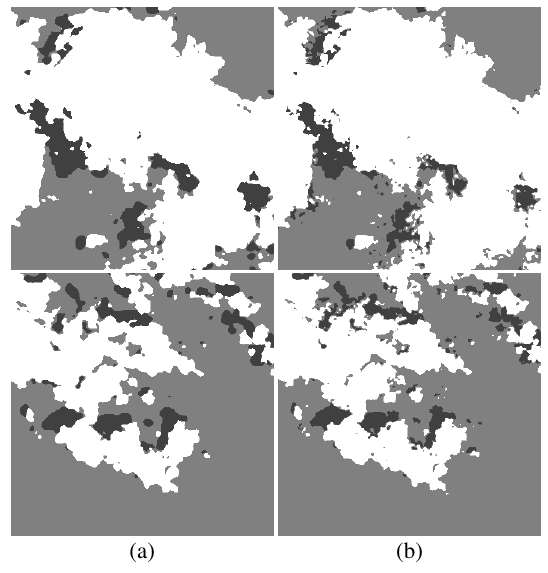
Figure 6. Zoom views of two sites in cloud detection results of the SPARCS. Column (a) is the results of UNet; Column (b) is the result of